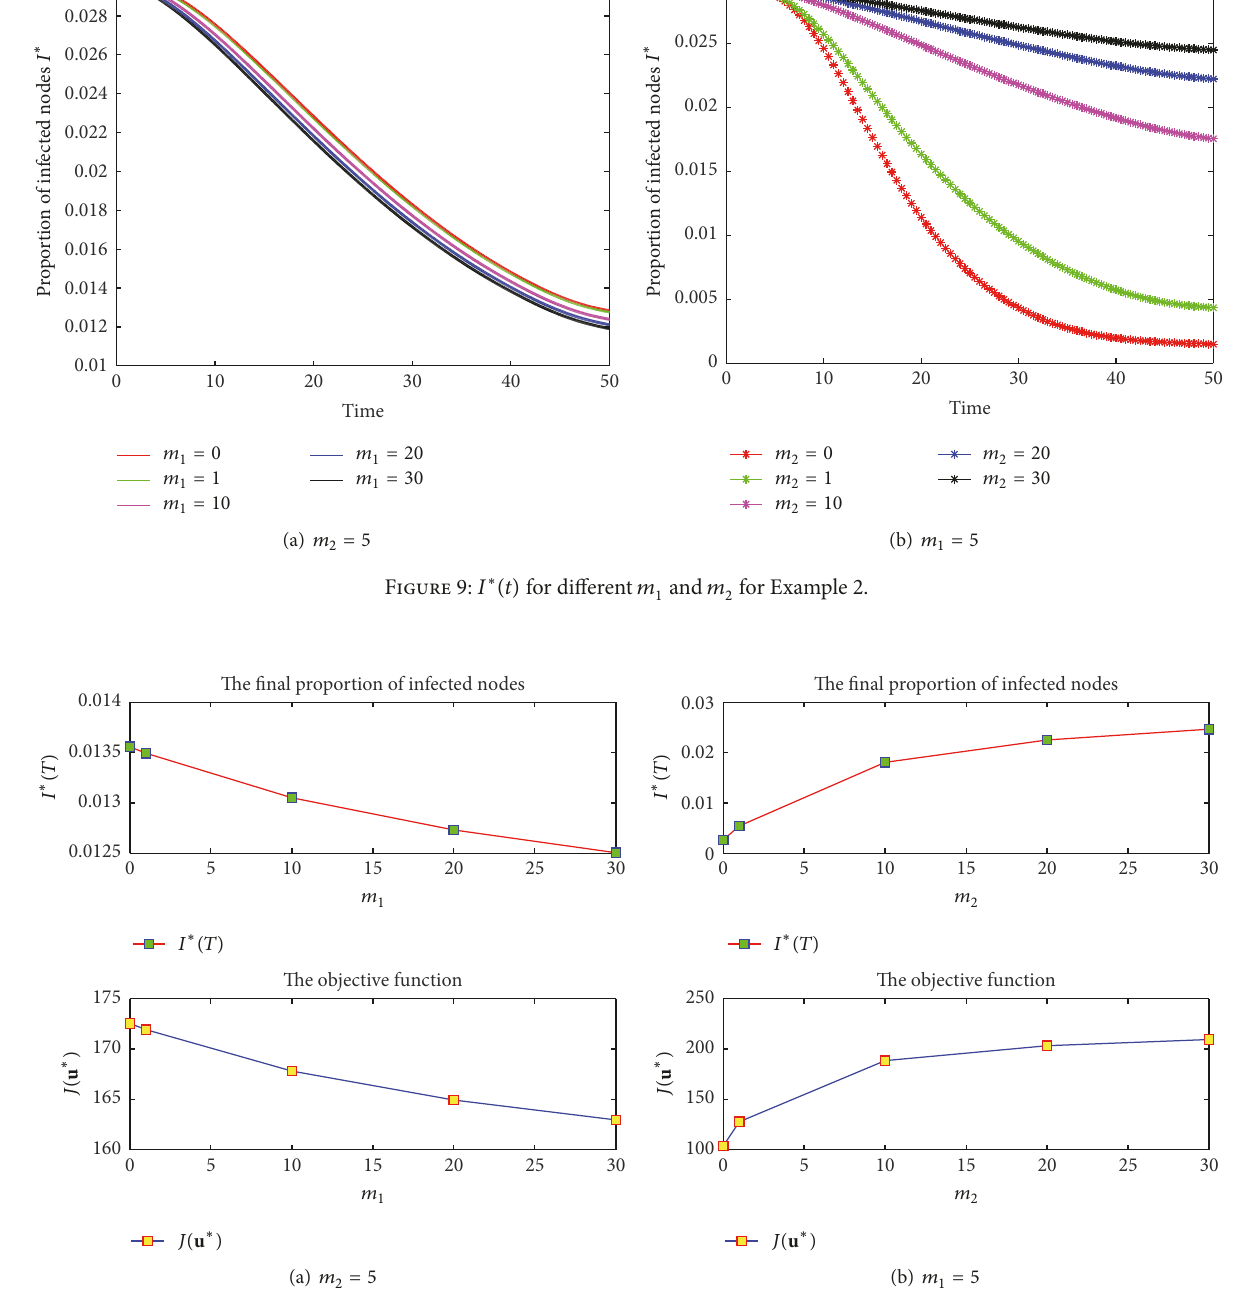
Figure 10: 𝐼 ∗ (𝑇) and 𝐽( u ∗ ) for different 𝑚 1 and 𝑚 2 for Example